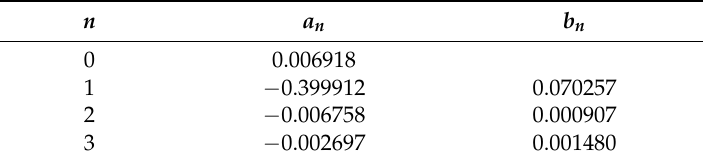
Table 1. Values of coefficient a and b.